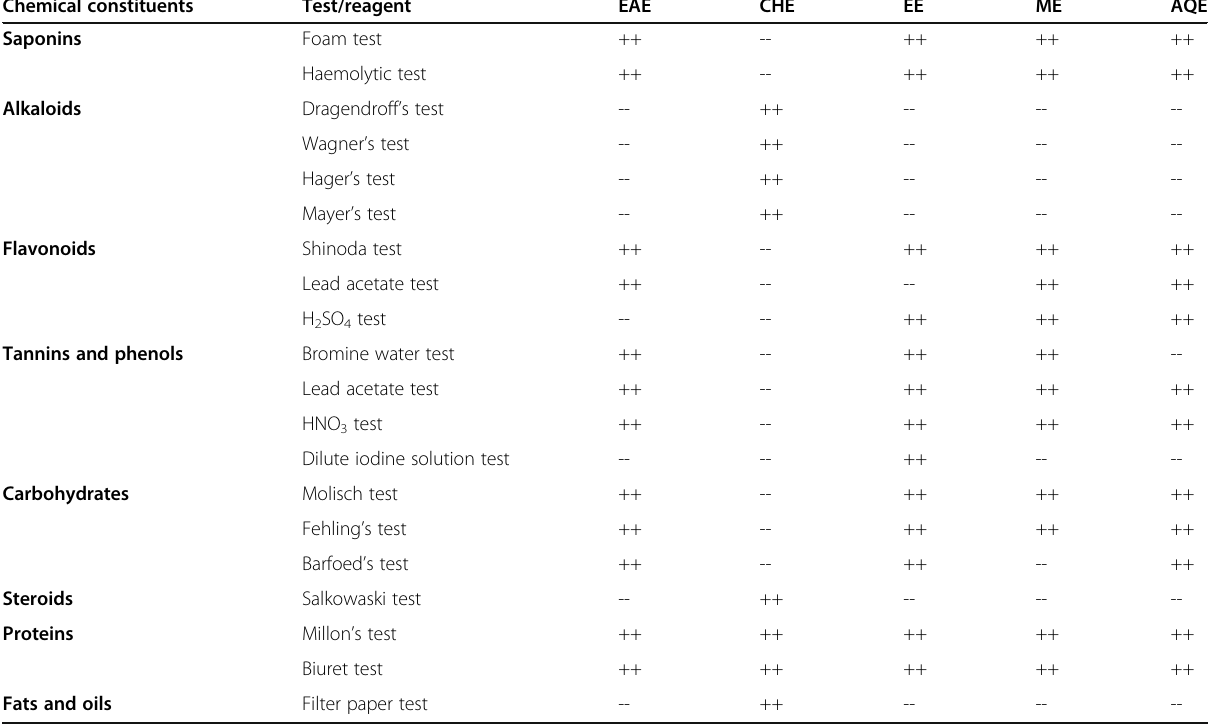
Table 1 Phytochemical analysis of C. zeylanica